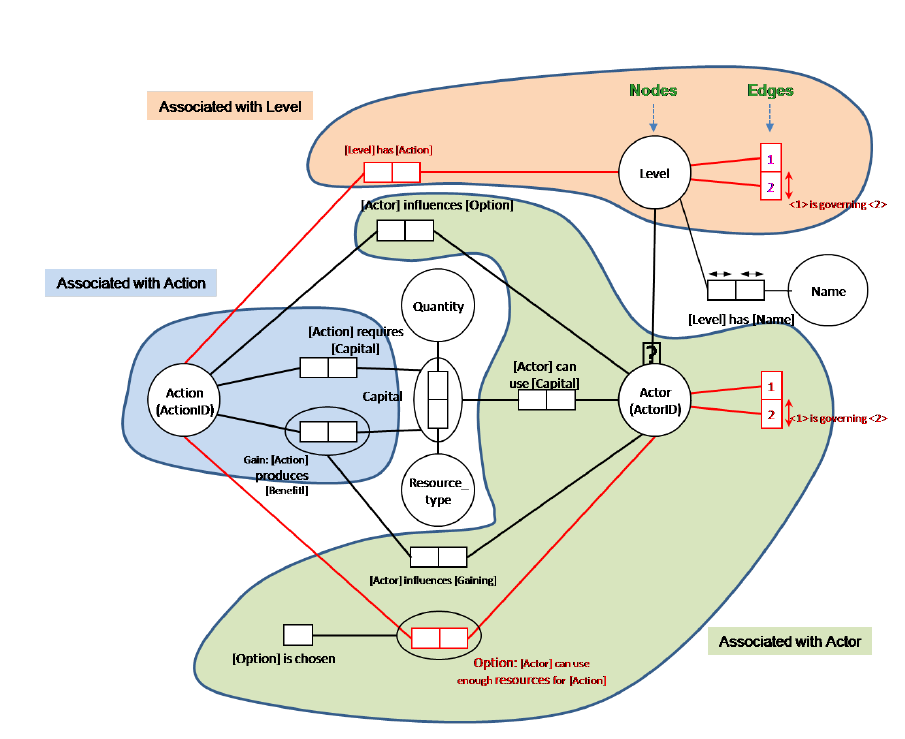
Figure 7. Grouping the fact